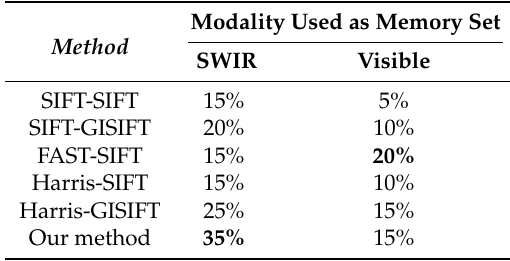
Table 4. Results (matching ratio) on Long-Term